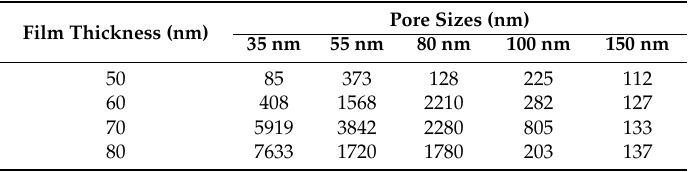
Figure 10. Peak SERS intensities measured at 1361 cm − 1 measured from 8 × 10 − 5 M solution of Rh6G dye adsorbed on the surface of 50–80 nm thick gold films deposited on 35, 55, 80, 100, and 150 nm pore size substrate at 3 s integration time. Table 1. Relative performance of the 50–80 nm thickness gold coated substrates measured by the intensity of 1361 cm − 1 .